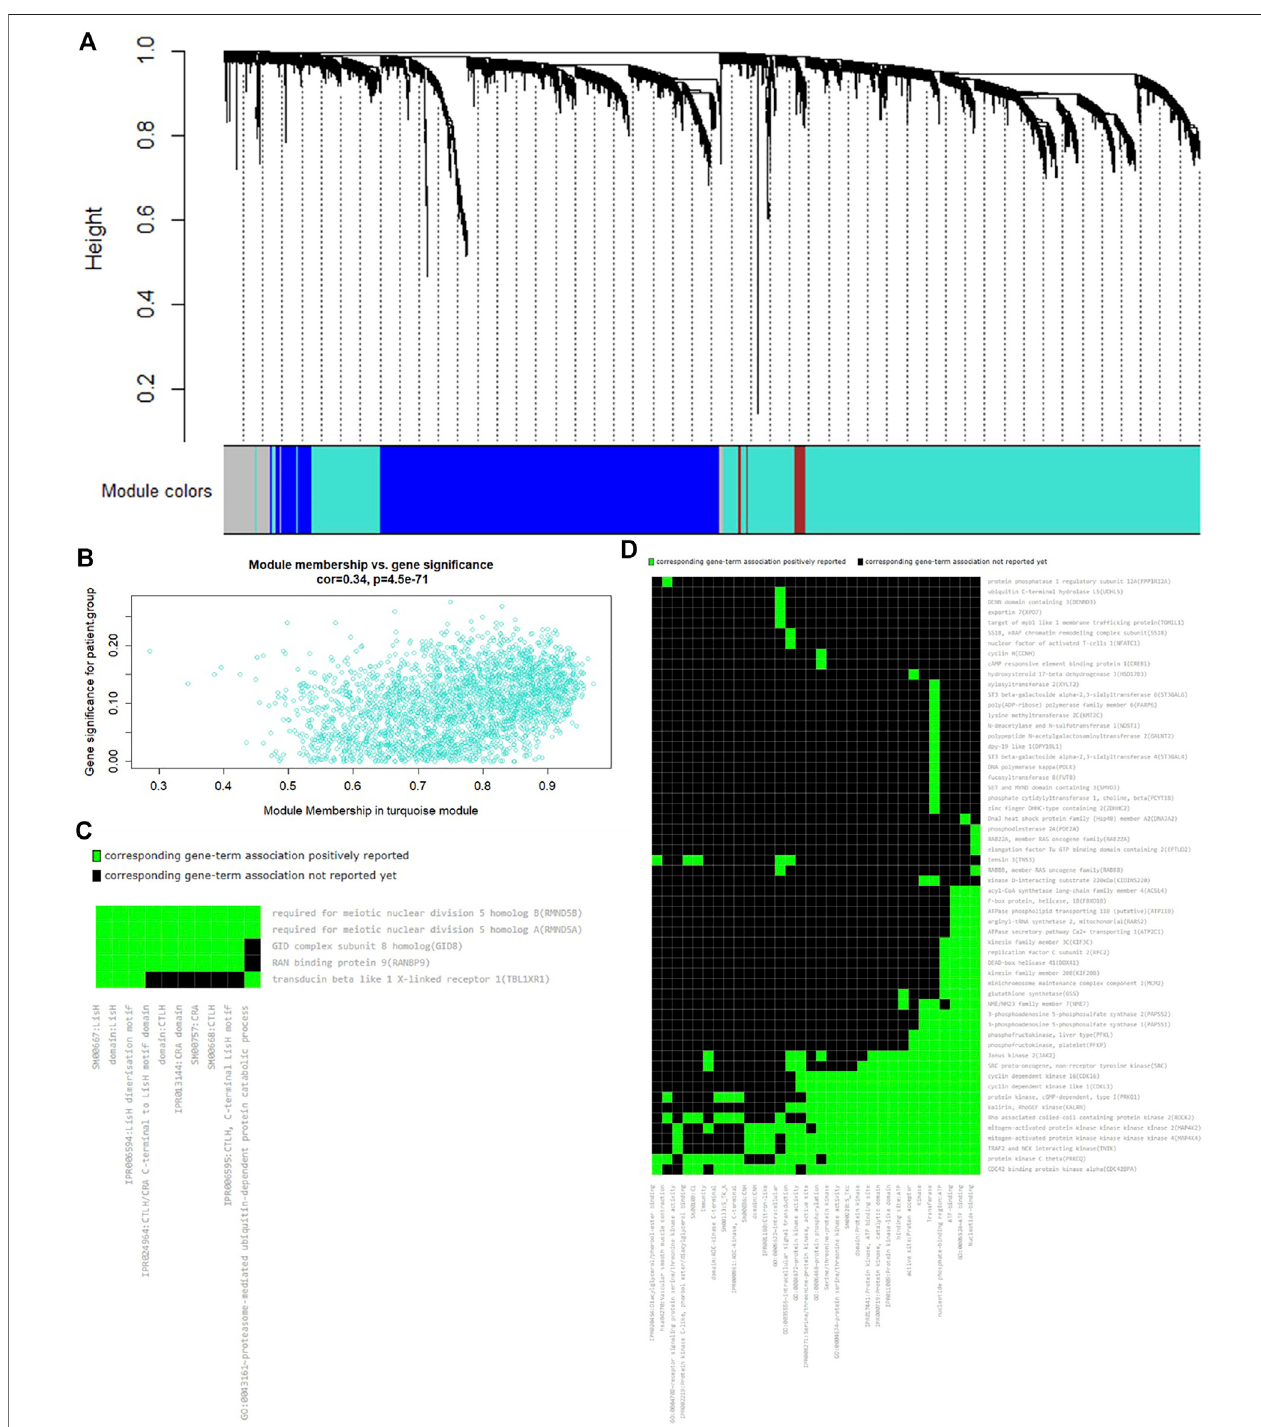
FIGURE 4 | The results of WGCNA and GSEA. (A) The expression clustering dendrogram of all 4722 genes in the GSE89843 data set. There are four clustered modules in the hierarchical clustering dendrogram, which contain 360 of 482 affected AS events corresponding genes. These clustered modules are marked as four different colors, respectively, i.e., turquoise, blue, brown, and grey. (B) The correlation between the module membership and the gene signi fi cance in the turquoise module, which reveals a relatively strong correlation with the disease status (cor (cid:2) 0.34 and p (cid:2) 4.5 × 10 − 71 ). The gene signi fi cance is de fi ned as the correlation between a single gene expression and sample trait (e.g., gender, age, and disease status) (C) The annotation cluster 1 contains 10 functionally highly similar enriched termsinvolvedintheprotein – proteininteractiondomainmotif.( D )Theannotationcluster2contains32functionallyhighlysimilarenrichedtermsinvolvedinproteinkinase and phosphorylation modi fi cation. This fi gure can be viewed more clearly by enlarging in the electronic version.